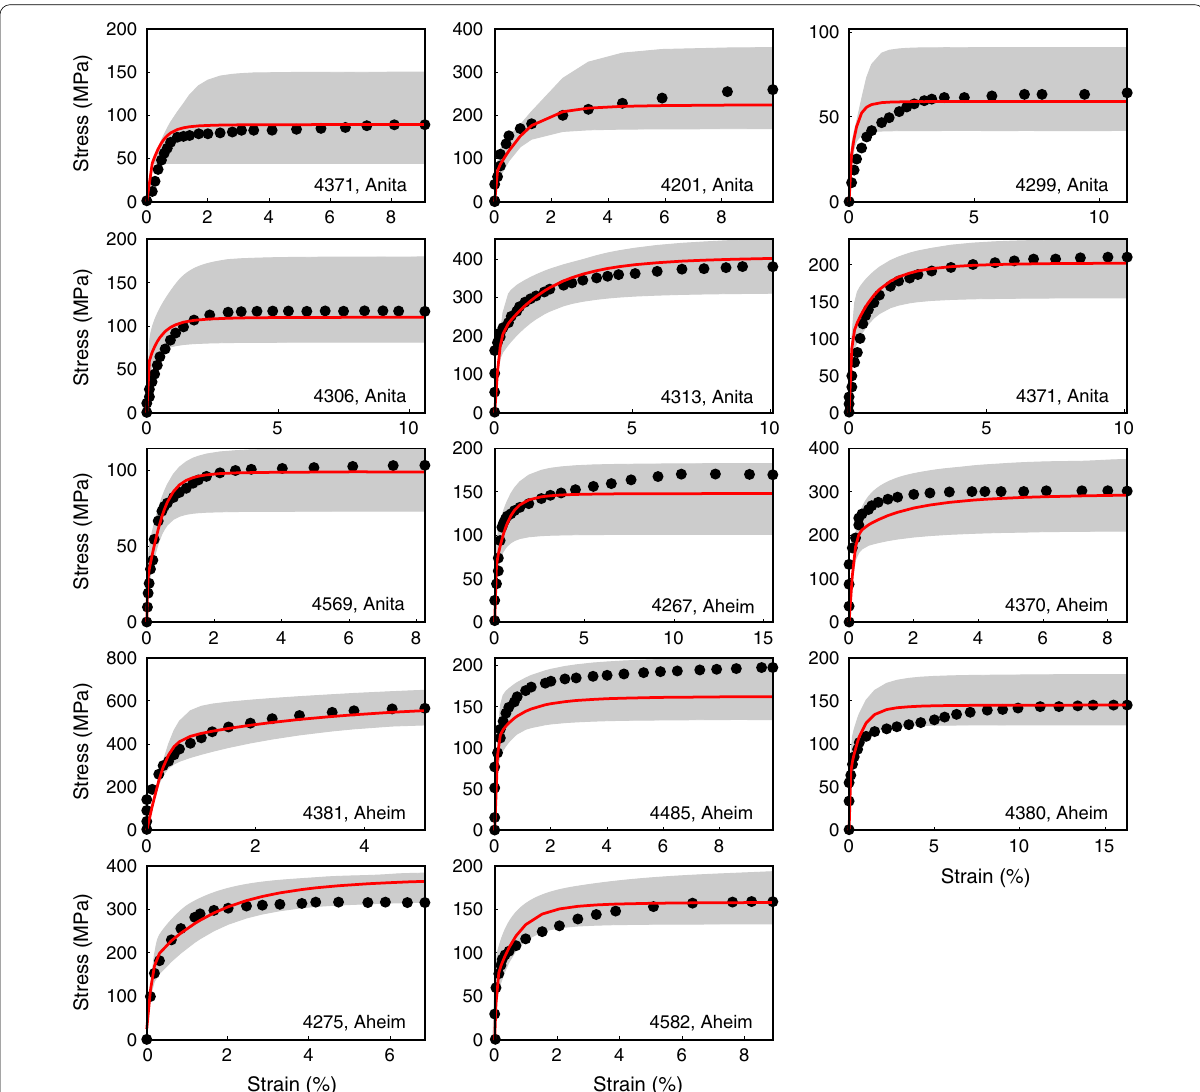
Fig. 8 Stress-versus-strain series (black dots) for wet dunites with best-fit model. The red line represents the prediction of the best-fit model based on the grain-size sensitive nonlinear Burgers rheology. The grey bands represent the confidence interval, which is plotted by randomly sampling the posterior distribution taking the covariance into account. The experiments were conducted on samples with different grain sizes (Åheim with 900 µ m grain size and Anita Bay with 100 µ m grain